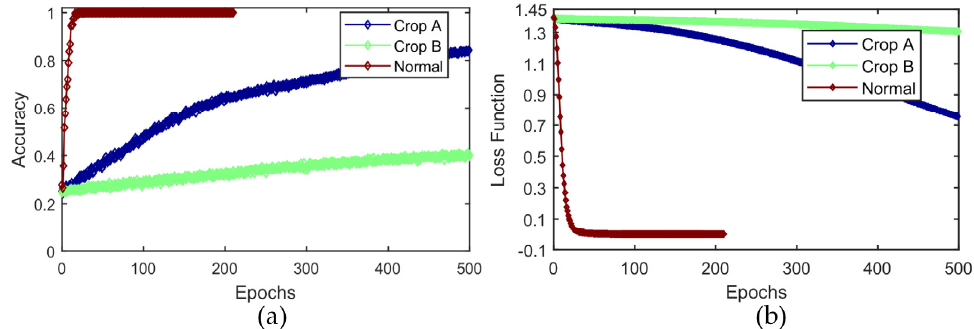
Figure 8. Comparison of prediction results of two cutting methods for graphical samples. ( a ) Train Accuracy. ( b ) Train Loss. Accuracy. ( b ) Train